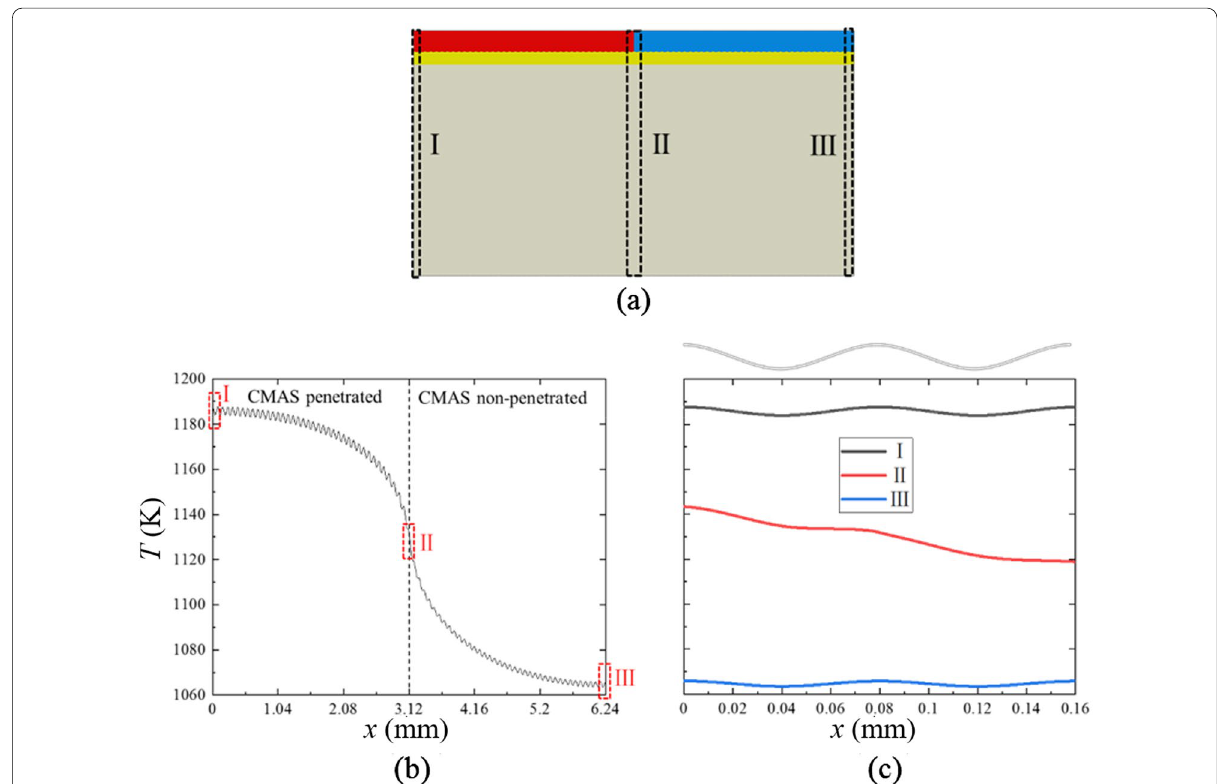
Figure 5 ( a ) Critical zones: I, II and III, ( b ) temperature distribution at interface of multi-period model after heating, ( c ) interface temperature distribution in three critical zones: I, II, and